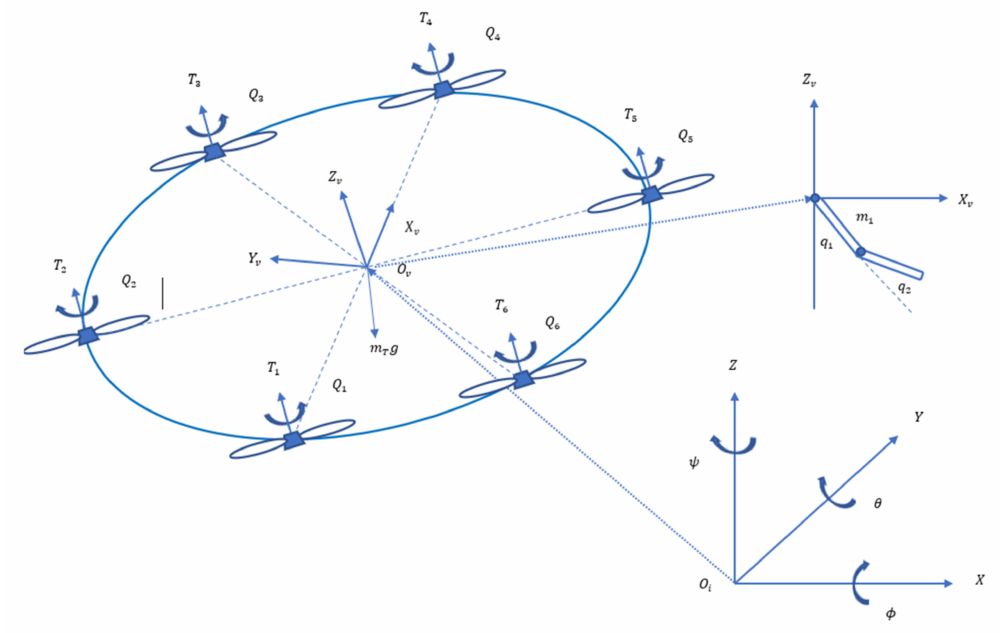
Figure 1. Model of aerial